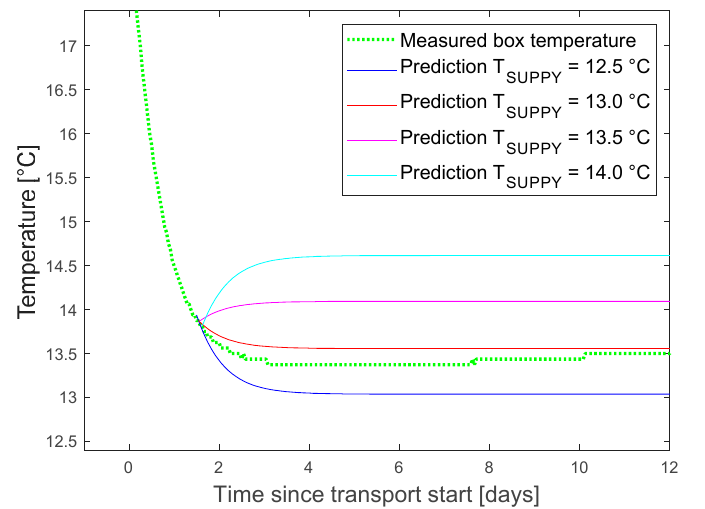
Figure 9. What-if scenario for testing setpoint changes, 1.5 days after transport start. Measured box temperature (green) for supply air with average 13.2 °C, see black line in Figure 7 left.